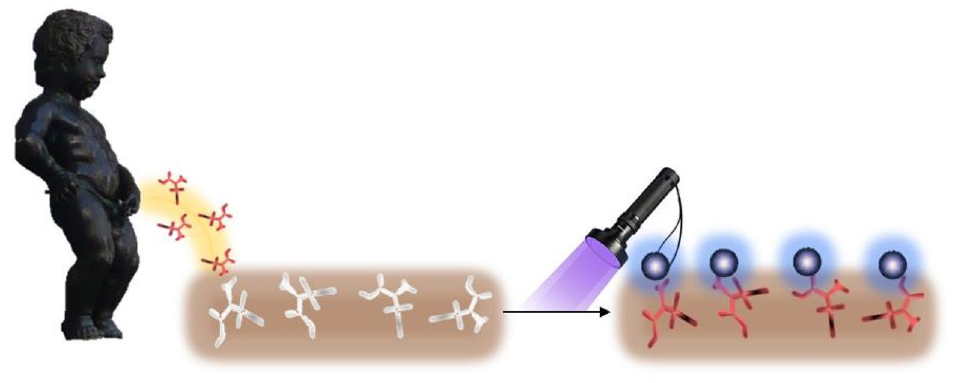
Figure 1. Schematic representation of overall